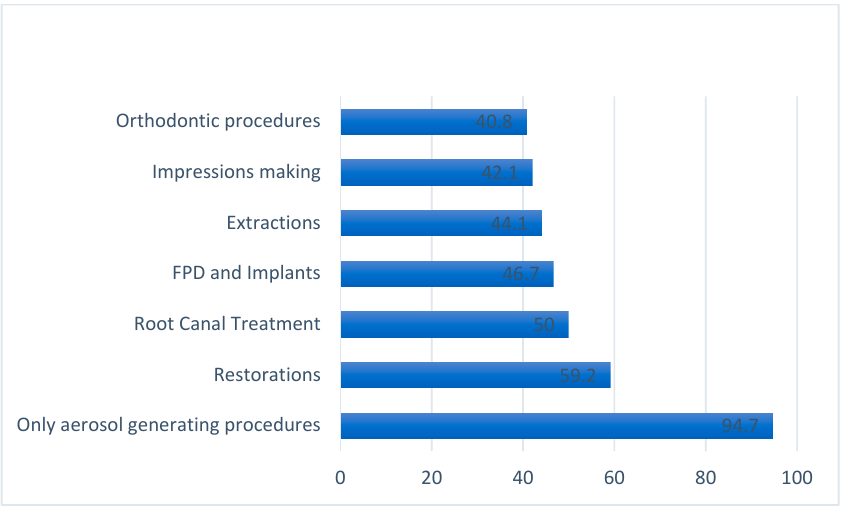
Figure 1. Participants’ knowledge of procedures that carry the highest risk of transmission of COVID-19.